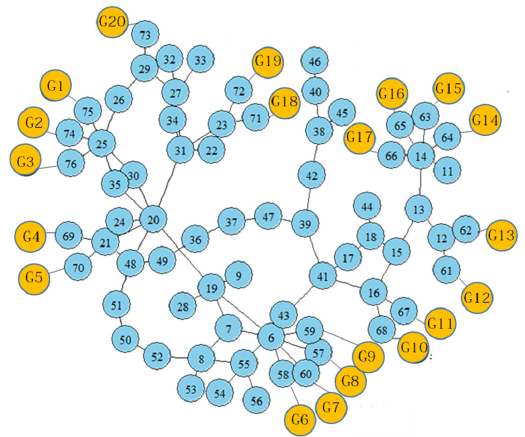
Figure 7. Adjacency matrix of the eastern regions.